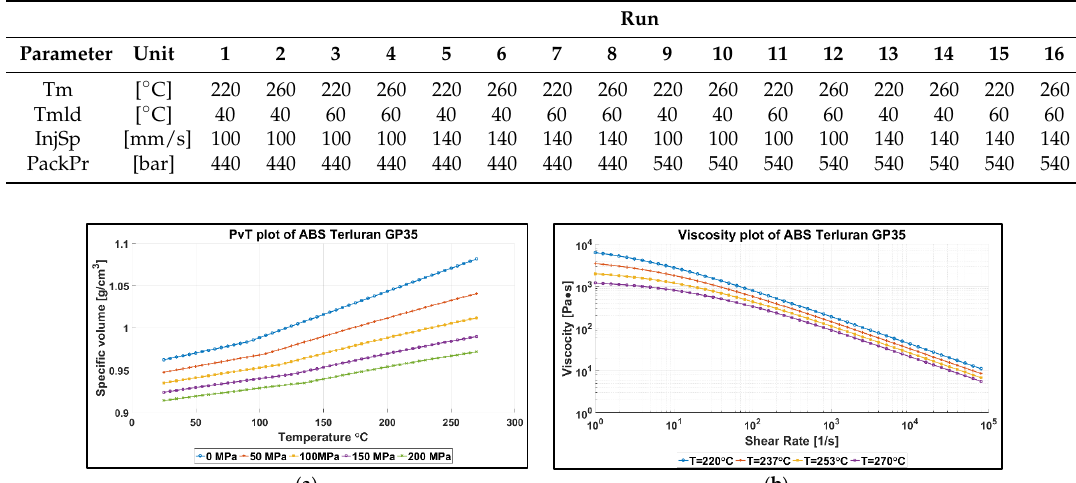
Table 1. Experimental Parameters.